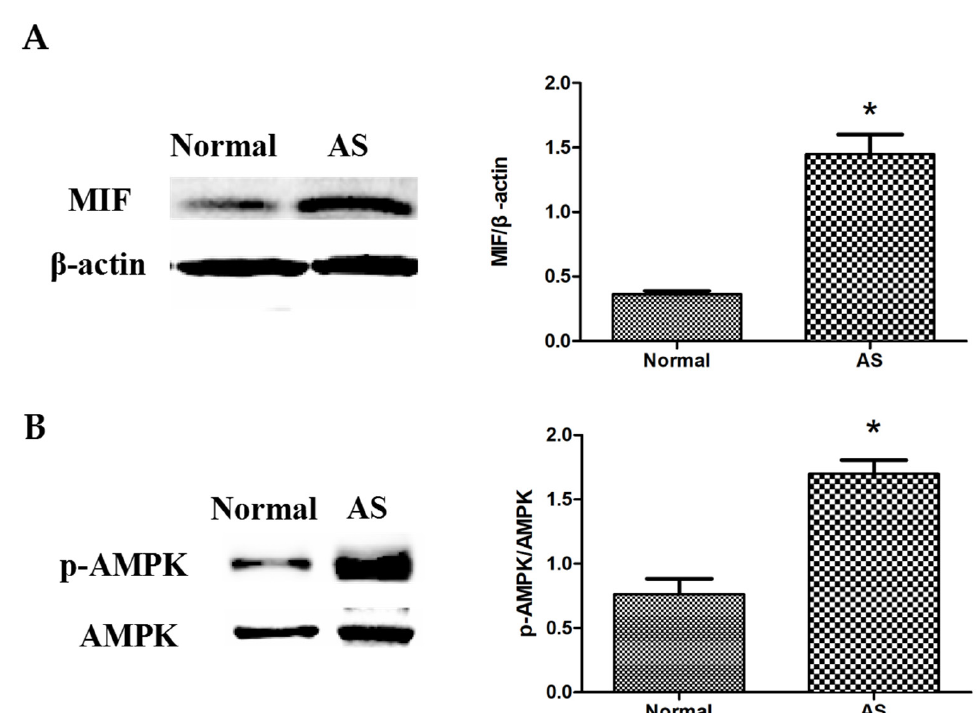
Figure 3. The protein expressions of MIF and p-AMPK in the control group and AS group were measured using Western blotting: ( A ) MIF; ( B ) p-AMPK and AMPK. The data are presented as the means ± SEM. The experiment was repeated three times independently. * p < 0.05 indicates a significant difference from the control group.